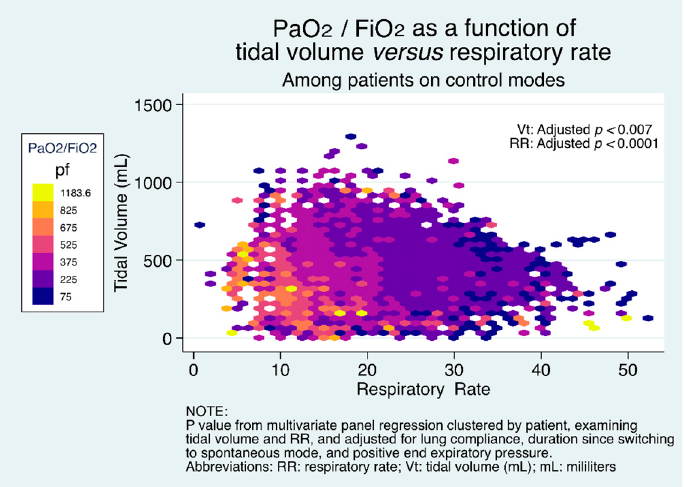
Figure 6. PaO 2 /FiO 2 as a function of the combination of respiratory rate and tidal volume among patients on control mode.